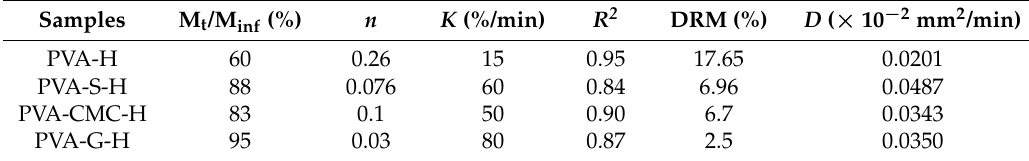
Table 5. Kinetics parameters of the model representing honey delivery from the samples.